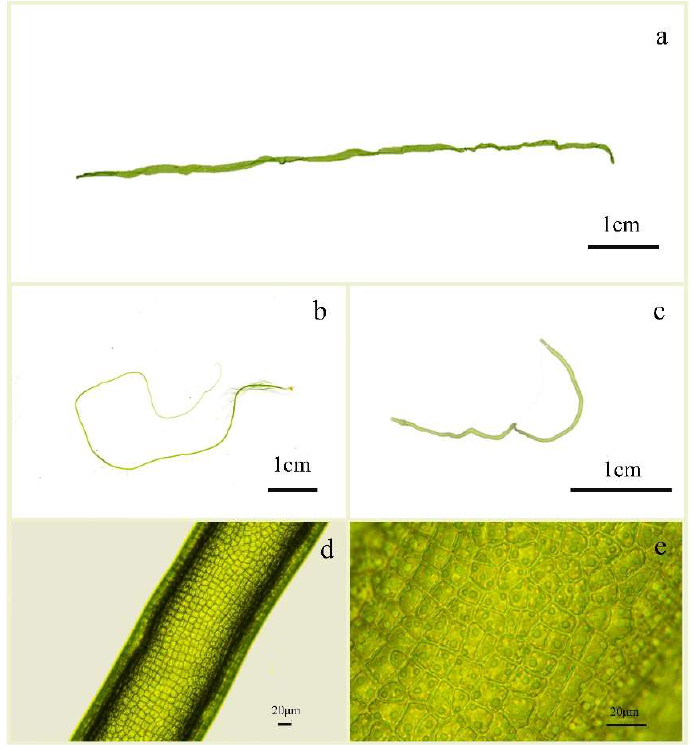
Figure 2. Morphology and cell diagram of U. aragoensis and U. flexuosa subp. flexuosa ; ( a ) Morphology of U. aragoensis floating in the early-stage green tide of the Southern Yellow Sea. ( b ) Micro-propagules of U. aragoensis cultured from the surface seawater in the area of green tide outbreak in the Southern Yellow Sea. ( c ) Morphology of U. flexuosa subp. flexuosa . cultured from the surface seawater in the Southern Yellow Sea. ( d ) The middle part of U. aragoensis under a microscope at 40 × 10 magnification. ( e ) The middle part of U. aragoensis under a microscope at 10 × 10 magnification.